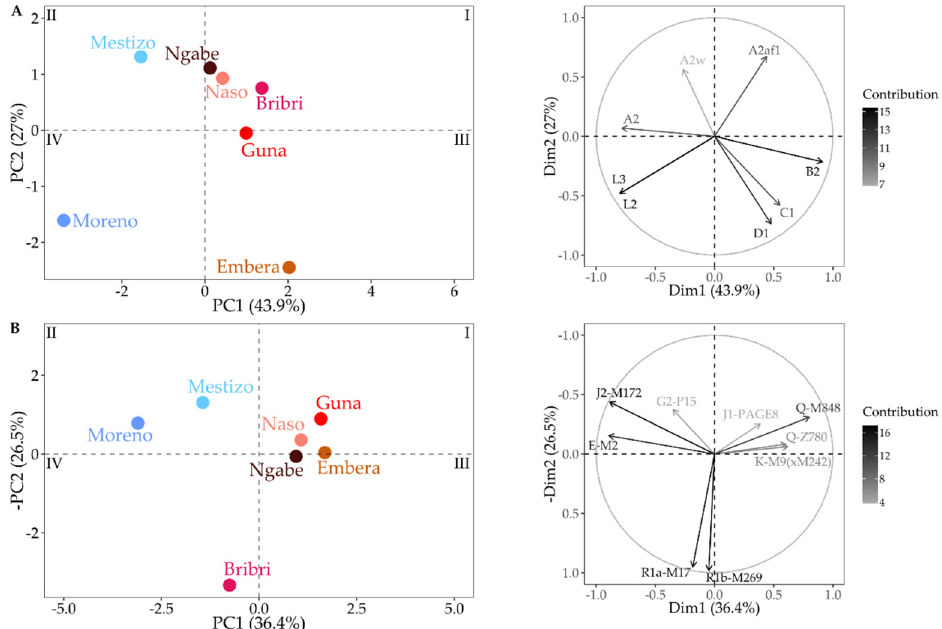
Figure 7. PCA computed on haplogroup frequencies of mtDNA ( A ) and Y-chromosome ( B ). The graphs on the right represent the variable correlation plots, which are colored according to the variables’ contribution to PC1 and PC2.